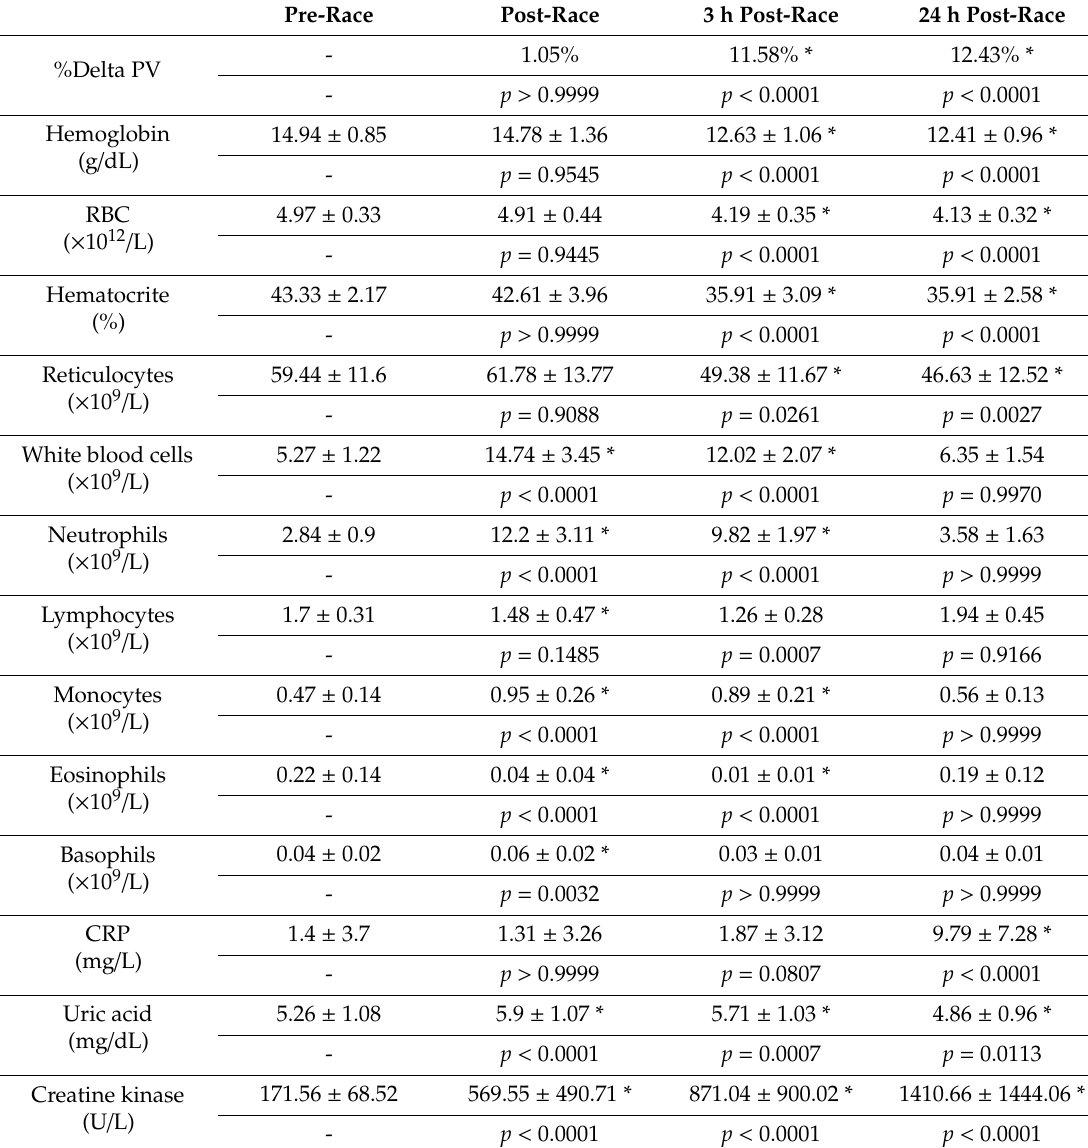
Table 2. Changes in laboratory parameters after a marathon run ( n = 24). p < 0.05 is statistically significant. Data are presented as the mean ± SD for the pre-race and the three following measurements. Values are corrected for plasma volume changes (%Delta PV). Statistical analyses were undertaken using Tukey’s multiple comparisons test for the parametric values and Dunn’s multiple comparisons test for nonparametric values, compared to the pre-race values. * p < 0.05. Pre-Race Post-Race 3 h Post-Race 24 h Post-Race